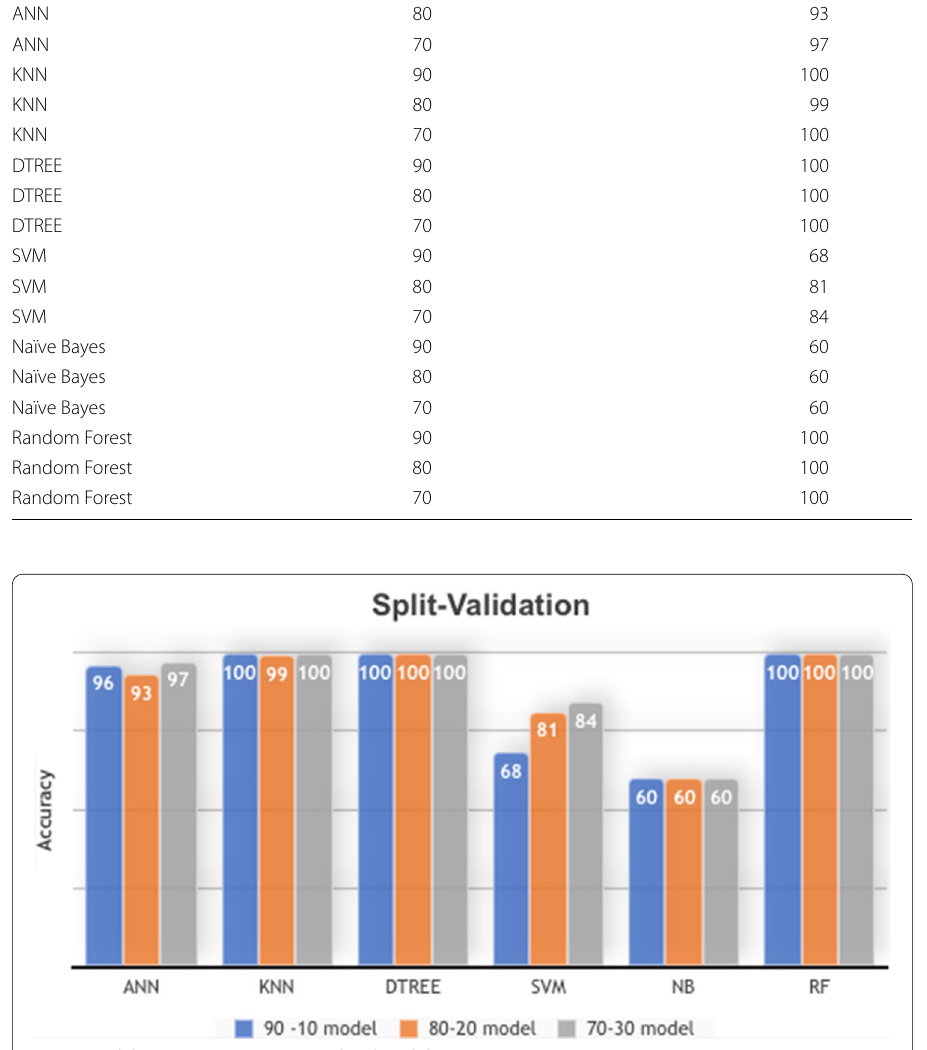
Fig. 6 Model accuracy comparison with